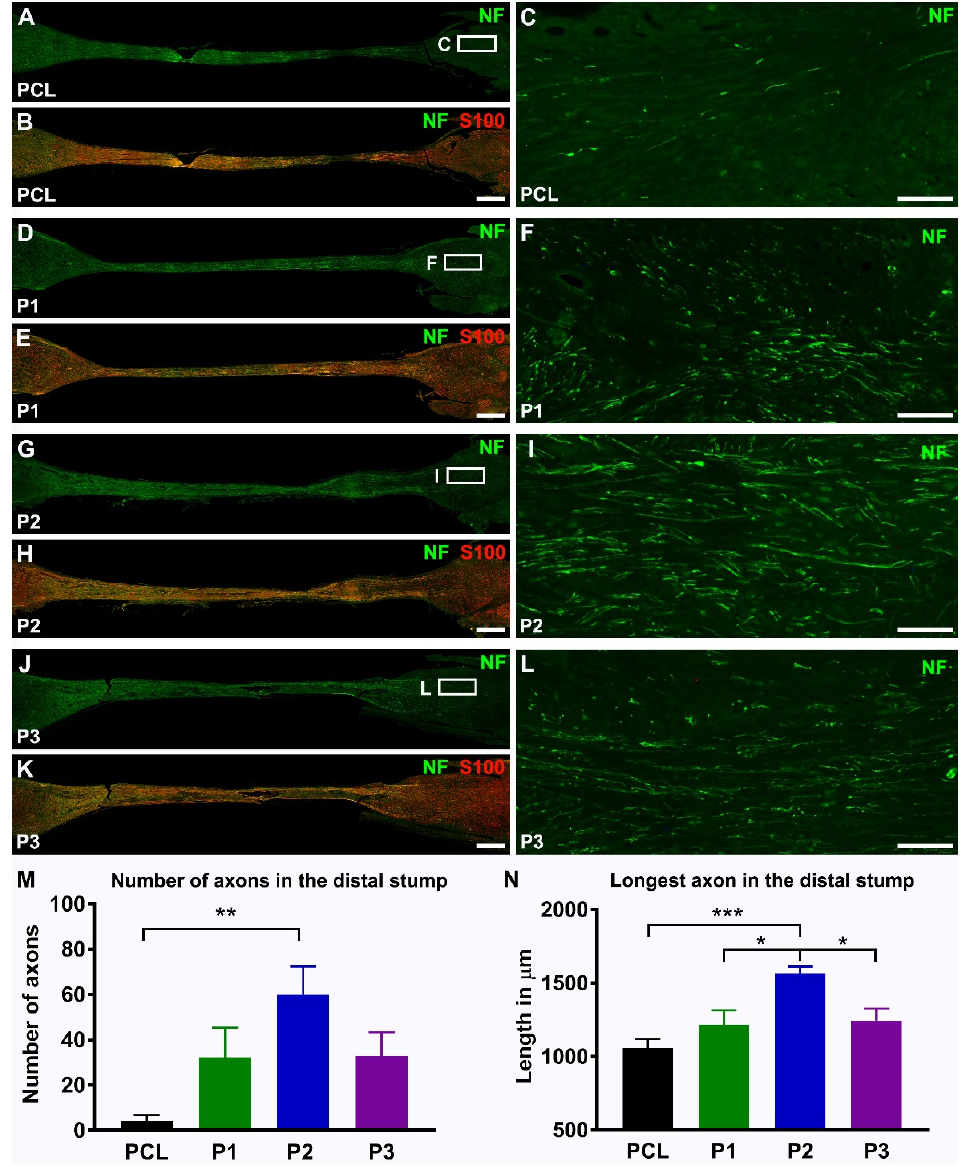
Figure 7. The effects of hydrogels implantation on regeneration into the distal nerve stump. Rep- resentative longitudinal sections demonstrate neurofilament-labelled axons alone (NF in A , D , G , J ) or in combination with S100-stained Schwann cells (S100 in B , E , H , K )) in the empty PCL conduit (PCL) and in PCL conduits filled with hydrogels (P1, P2, and P3) at 3 weeks following nerve injury and repair. Boxed areas in ( A , D , G , J ) are enlarged in ( C , F , I , L ). Note that regenerating axons reached the distal nerve stump in all experimental groups. Histograms in ( M , N ) show the number of regeneration axons and the length of the longest axon in the distal nerve stump (PCL, n = 5, P1, n = 5, P2, n = 7, and P3, n = 7). Error bars represent the S.E.M. p -values are indicated as follows: * p ≤ 0.05, ** p ≤ 0.01, and *** p ≤ 0.001. Scale bars: 750 µ m in the images with conduit reconstructions and 100 µ m in the insertions from boxed